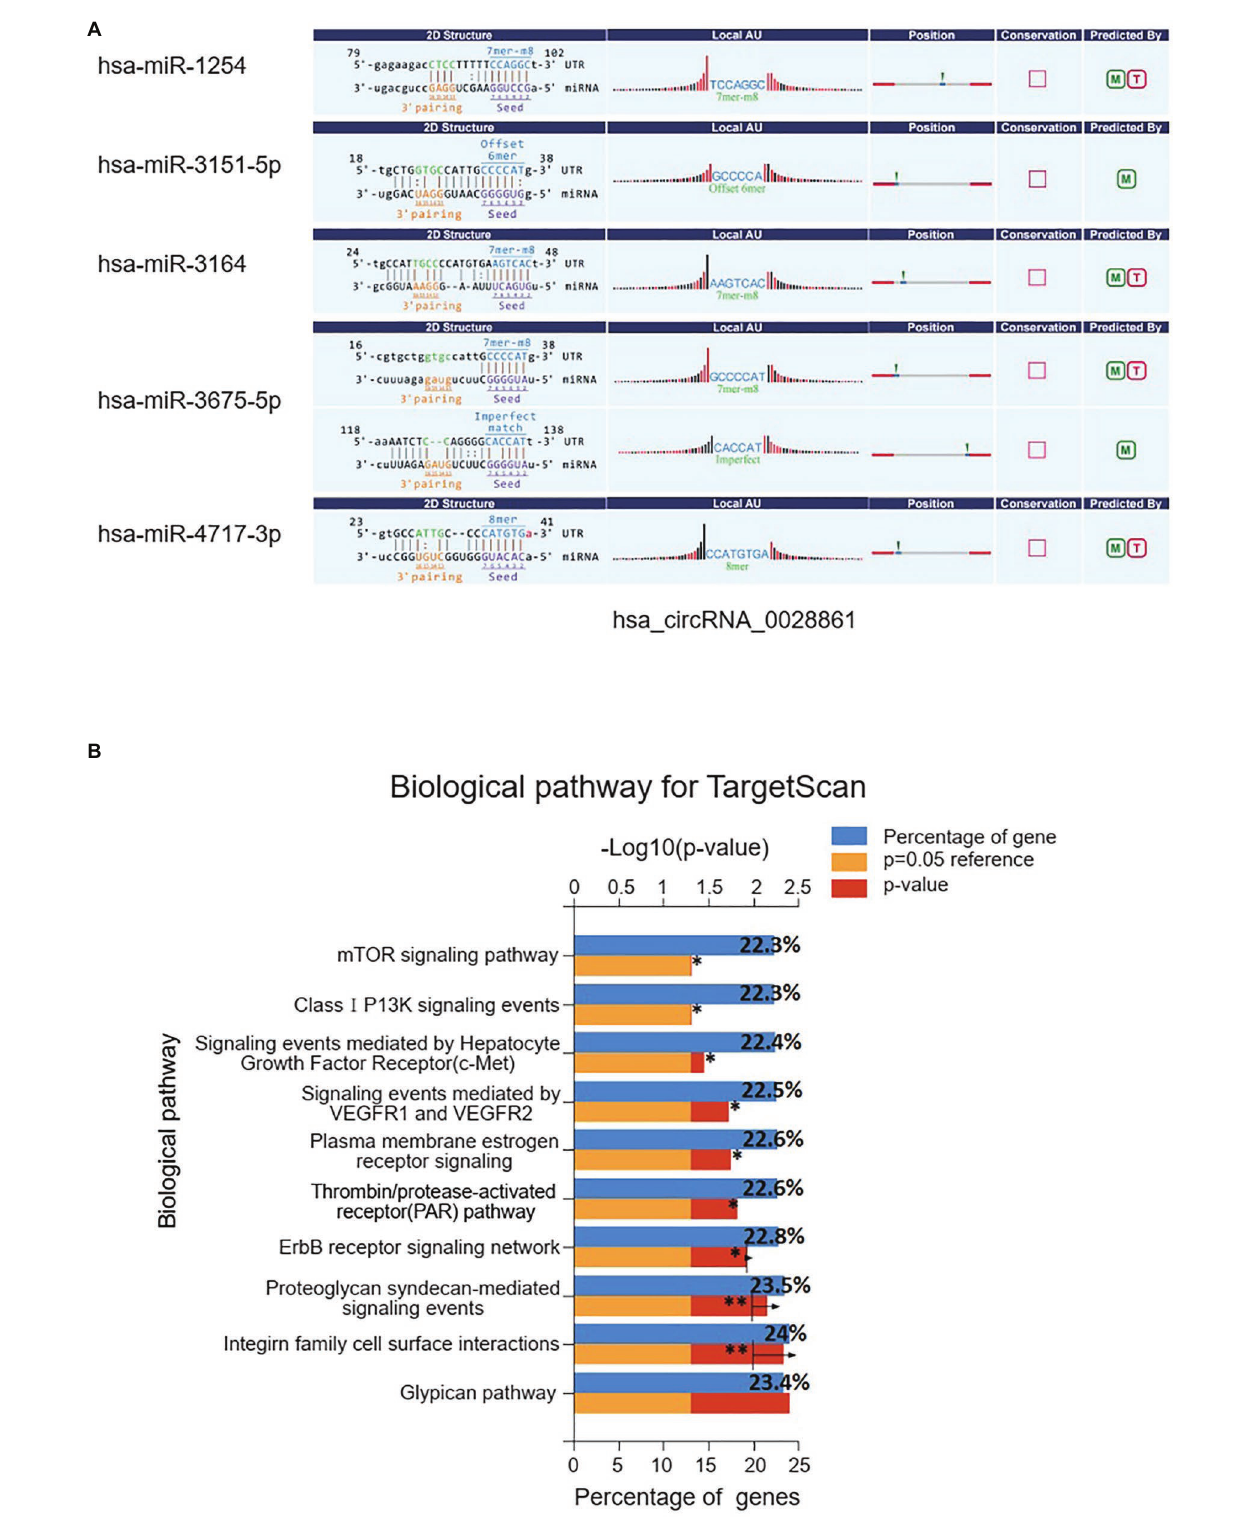
FIGURE 6 | Prediction of hsa_circ_0028861 interacted miRNAs and downstream biological pathway analysis. (A) There were five miRNAs identified as targets of hsa_circ_0028861; (B) pathway enrichment analysis of the targeted mRNAs (predicted by TargetScan) of these five miRNAs suggested that hsa_circ_0028861 participated in the integrin, VEGF, PI3K/Akt and mTOR signaling pathways. * p < 0.05; ** p <